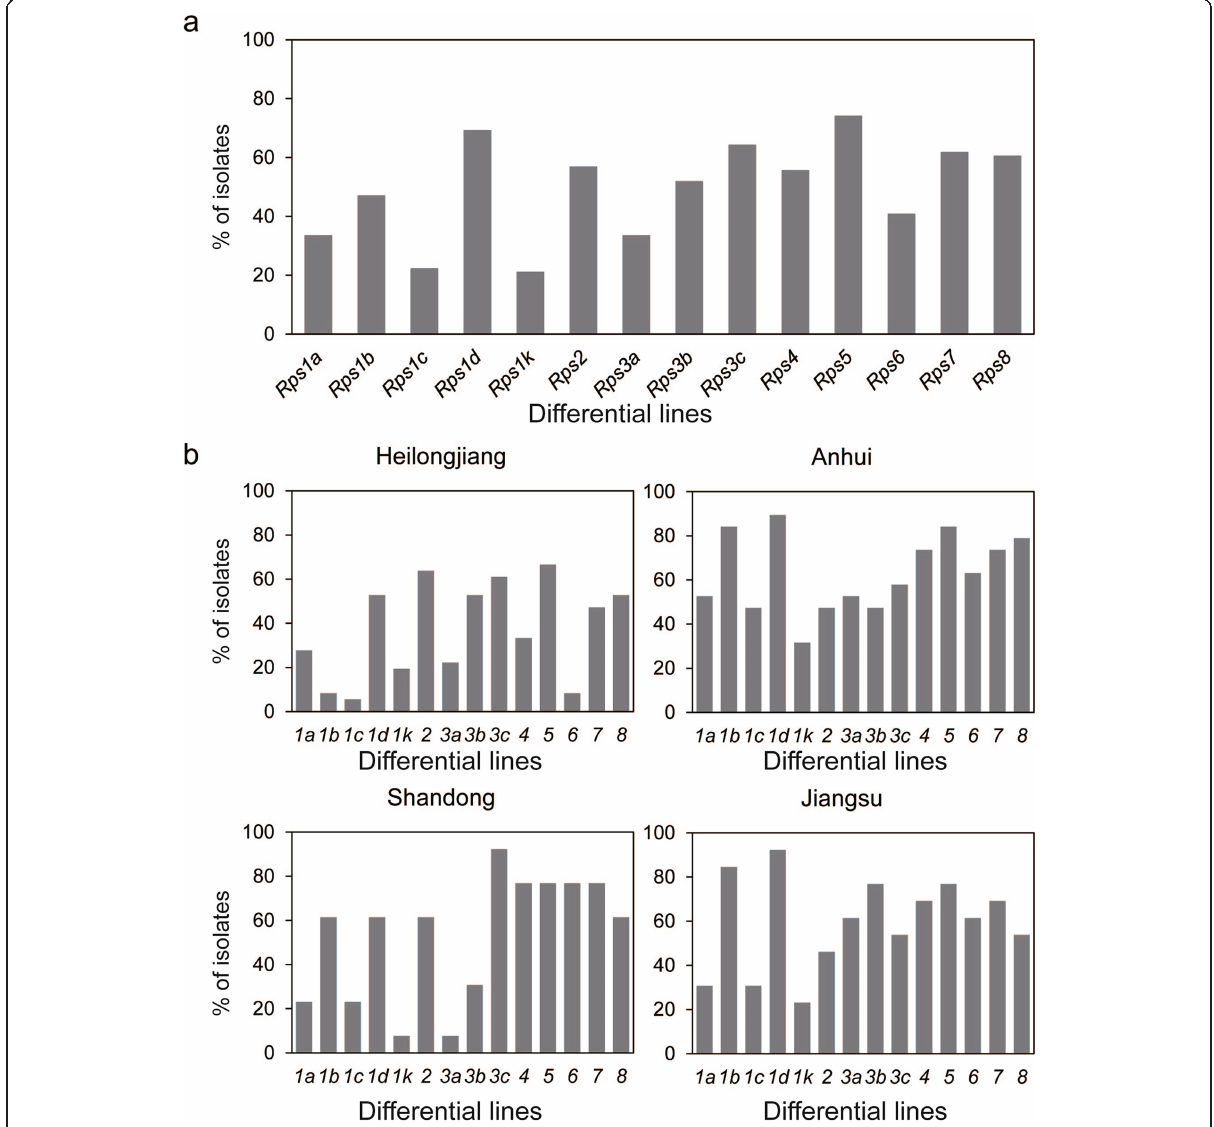
Fig. 1 The virulence proportion of Phytophthora sojae isolates on 14 differential lines collected in China. a The virulence proportion of all 81 isolates and b Proportion of isolates collected in Heilongjiang, Anhui, Shandong, and Jiangsu Province on 14 differential lines. Every assay was repeated independently twice. The x-axis indicated the differential lines containing the 14 Rps